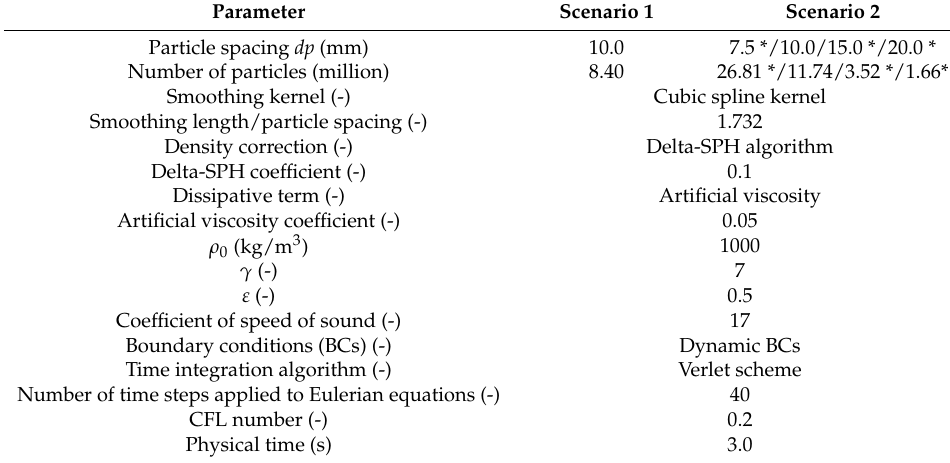
Table 1. Parameters used in DualSPHysics. The values marked with * were only used in the convergence tests. CFL: Courant–Friedrichs–Lewy, SPH: smoothed particle